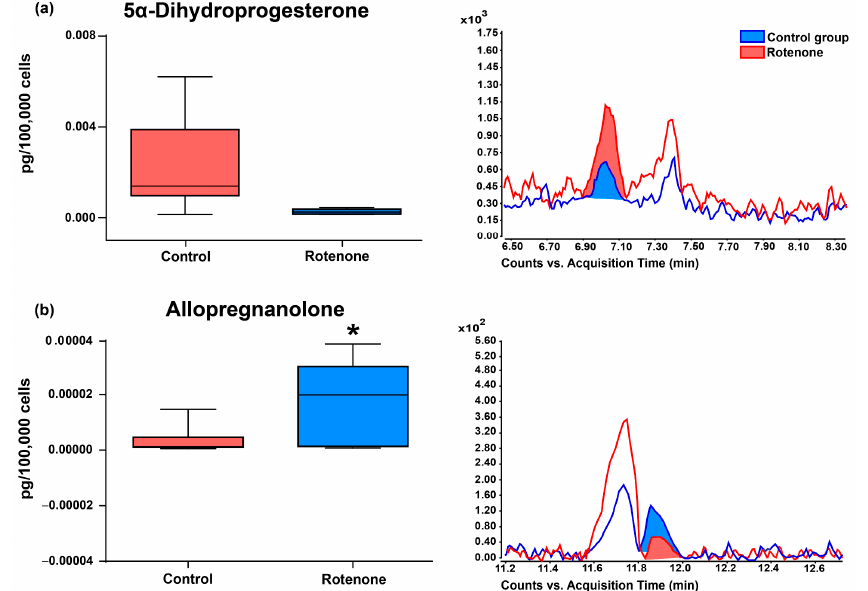
Figure 4. 5 α -Dihydroprogesterone (5 α -DHP) ( a ) and allopregnanolone ( b ) concentrations in HMC3 cells’ medium determined by LC-MS/MS in microglia in resting condition (Control) or after activation by exposure to rotenone for 24 h. In ( a ), 5 α -DHP levels, illustrated in the box plot, after stimulation with rotenone were lower but not significantly different when compared to the control group. Peak areas corresponding to the respective median values are illustrated on the right. In ( b ), allopreg- nanolone levels, illustrated in the box plot, were significantly reduced (* p < 0.05, Mann–Whitney rank sum test) after stimulation with rotenone. Peak areas corresponding to the respective median values are illustrated on the right. The neurosteroid concentrations are expressed in pg/100,000